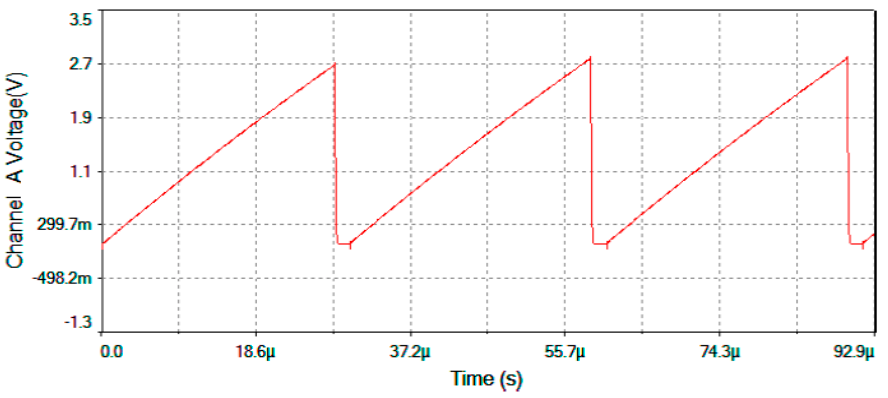
Figure 18. V theta output voltage after the Angle analog integrator for Ω = +30 °/s.